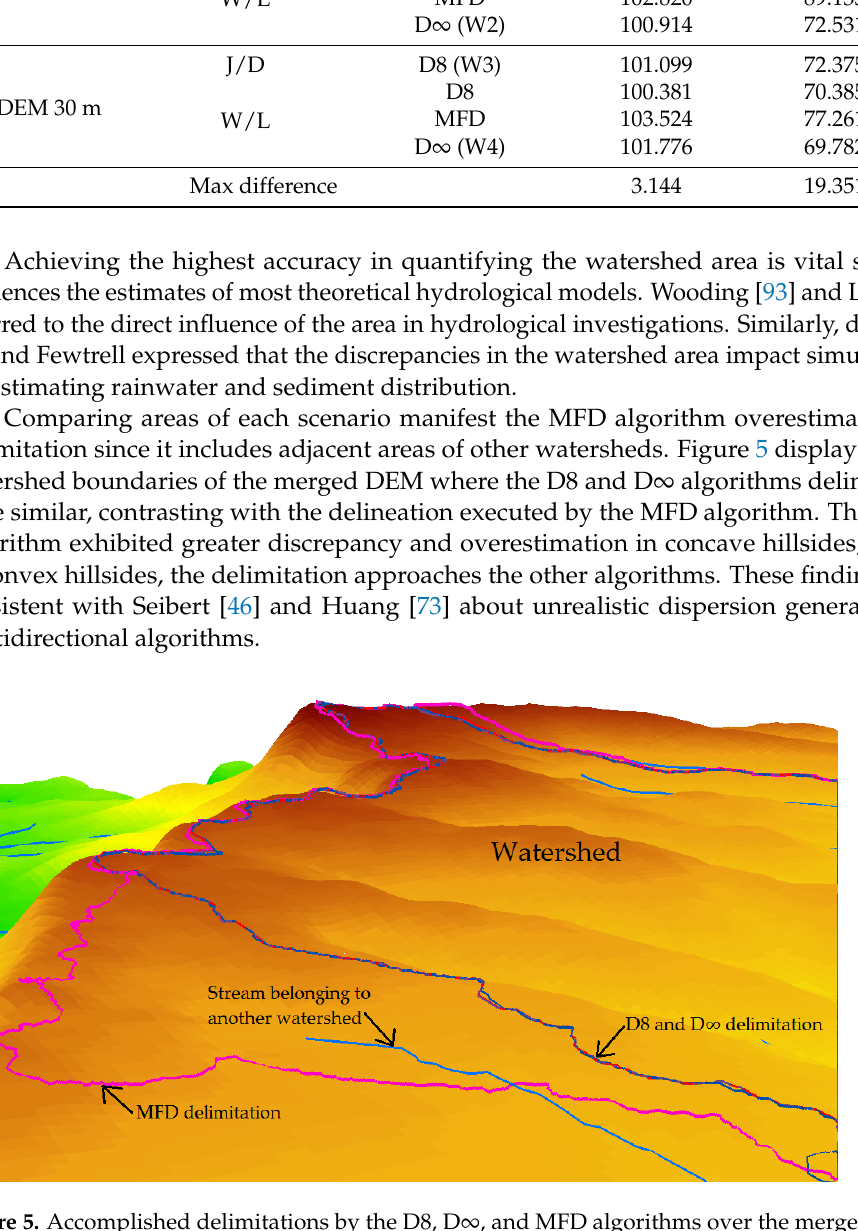
Table 6. Watershed area and perimeter calculation.